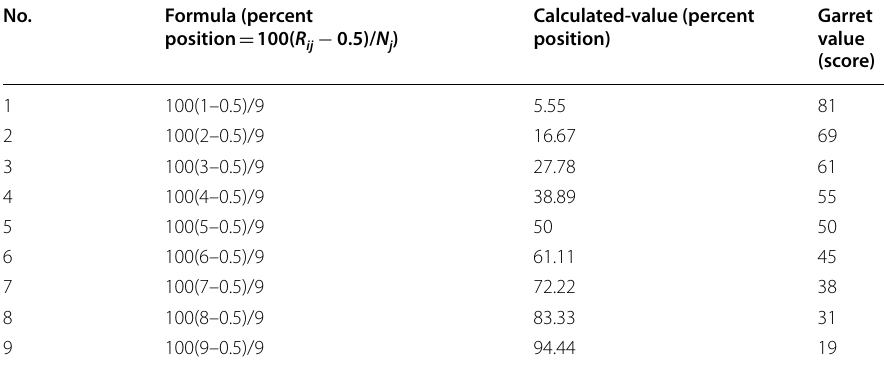
Percept position and Garret value calculation using appropriate Garret ranking formula and Garrett’s Table, 2021